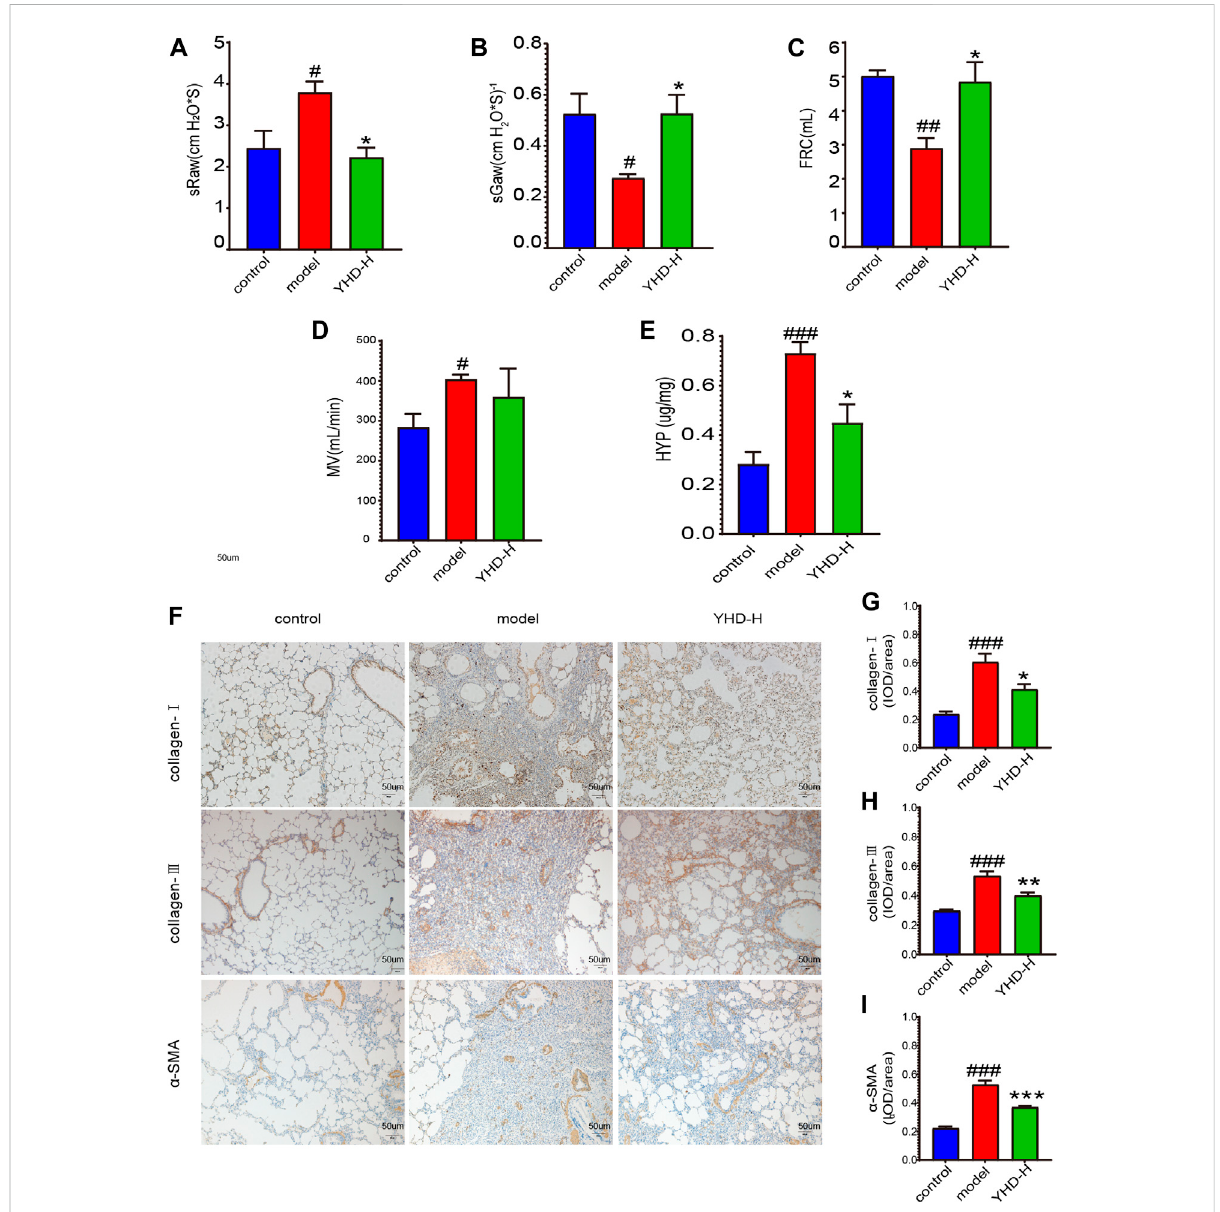
FIGURE 4 High-dose YHD improved lung function of fi brotic rats and inhibited collagen deposition in lung interstitium. (A – D) Lung function indicators: speci fi c airway resistance (sRaw), speci fi c airway conductance (sGaw), functional residual capacity (FRC), and minute volume (MV). (E) Hydroxyproline content. (F) Effects of high-dose YHD on pulmonary fi brosis by immunohistochemistry (scale bar = 50 um). (G – I) Image-Pro Plus softwarewasusedtostatisticallyanalyzetheimmunohistochemicalstainingresultsofcollagen- Ⅰ ,collagen- Ⅲ ,and α -SMA.Datawerepresented asthemeans±SEM( n =6).# p < 0.05,## p < 0.01,### p < 0.001,comparedwiththecontrolgroup;* p < 0.05,** p < 0.01,*** p < 0.01,comparedwith the model group,